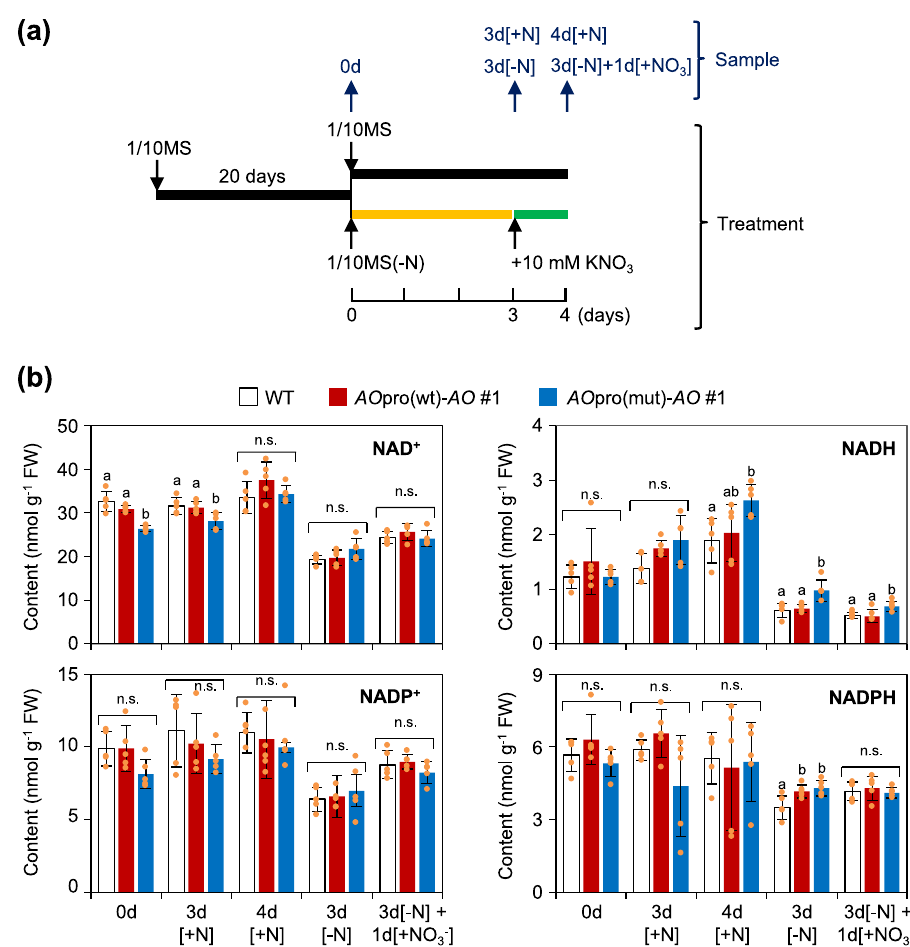
Fig. 5 Dynamics of shoot NAD(H) and NADP(H) contents in response to changes in the N environment. a Experimental scheme for sampling time and N conditions. Sample 0d, plants grown hydroponically on 1/10MS medium for 20 d; sample 3d[-N], plants grown for 3 d on N-free 1/10MS medium after cultivation on 1/10MS medium for 20 d; sample 3d[-N3] + 1d[KNO 3 - ], plants treated with 10 mM KNO 3 at day 23. Control samples 3d[ + N] and 4d[ + N] represent plants grown hydroponically on 1/10MS medium for 20 days and then on fresh 1/10MS medium for 3 or 4 days, respectively. b NAD + , NADH, NADP + , and NADPH contents of the whole shoots of WT, AO pro(wt)- AO , and AO pro(mut)- AO plants sampled according to the scheme in ( a ). Data represent mean ± SD ( n = 5). Different letters denote statistically signi fi cant differences (Tukey ’ s HSD test; P <